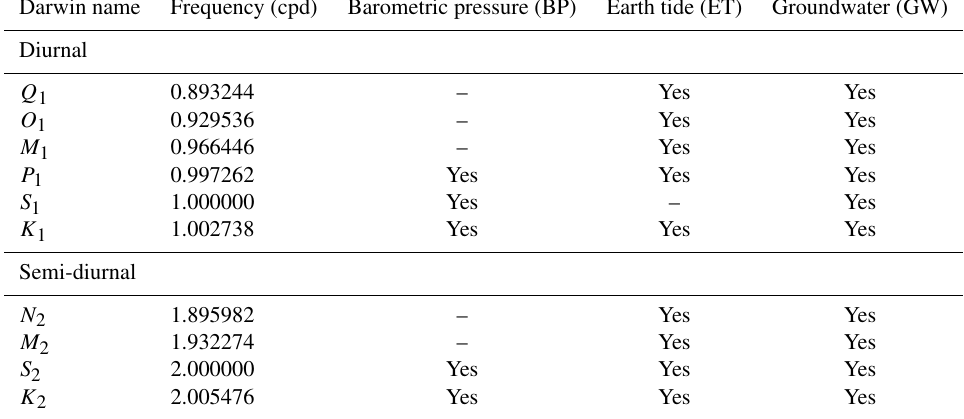
Table 1. Overview of the major tidal components found in well water levels (Merritt, 2004; McMillan et al., 2019) grouped by mode (diurnal and semi-diurnal) and ordered by frequency. Columns BP, ET and GW show which component can occur in what type of record. Note: cpd – cycle per